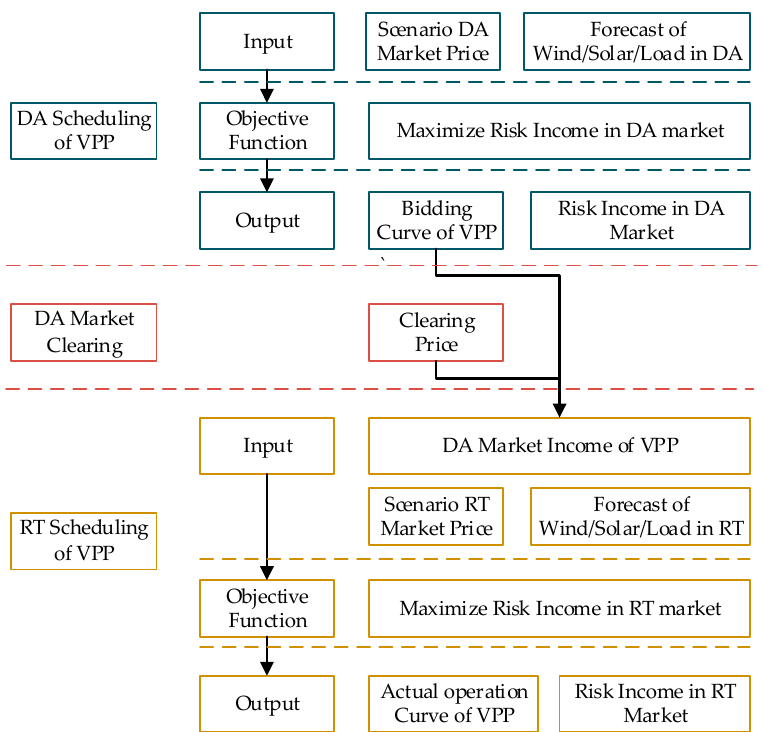
Figure 4. Solving framework of the optimization model.